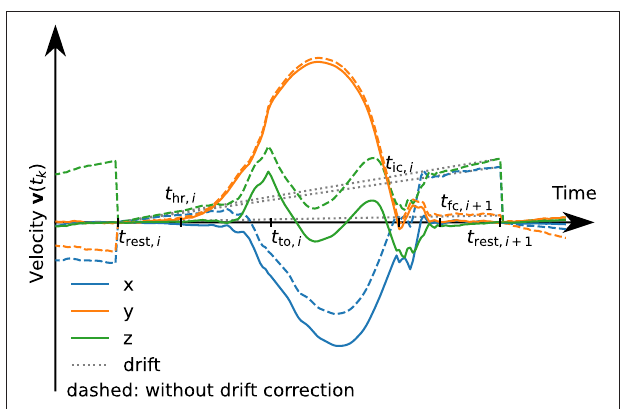
FIGURE 8 | Velocity trajectories with (solid) and without (dashed) linear drift correction. The dotted line represents the subtracted linear drift approximation for stride i . For demonstration purposes, the drift has been artificially increased by a factor of